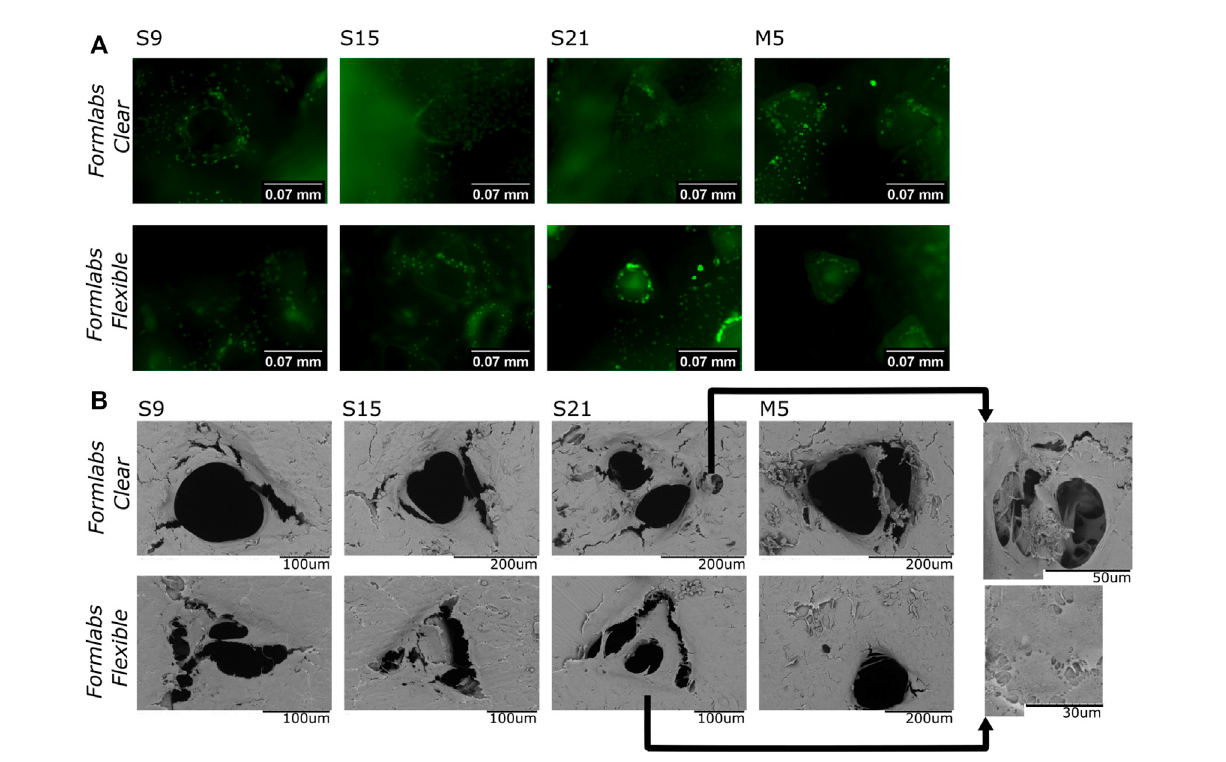
FIGURE 5 (A) -Results of fl uorescence microscopy studies. The image shows a merged view by focusing the objective at the bottom of the well, the surface of the scaffold ’ s bottomand face, and the interior of the pores. (B) – SEM analysis (representative images) of cells grown on different samples. S9, S15,